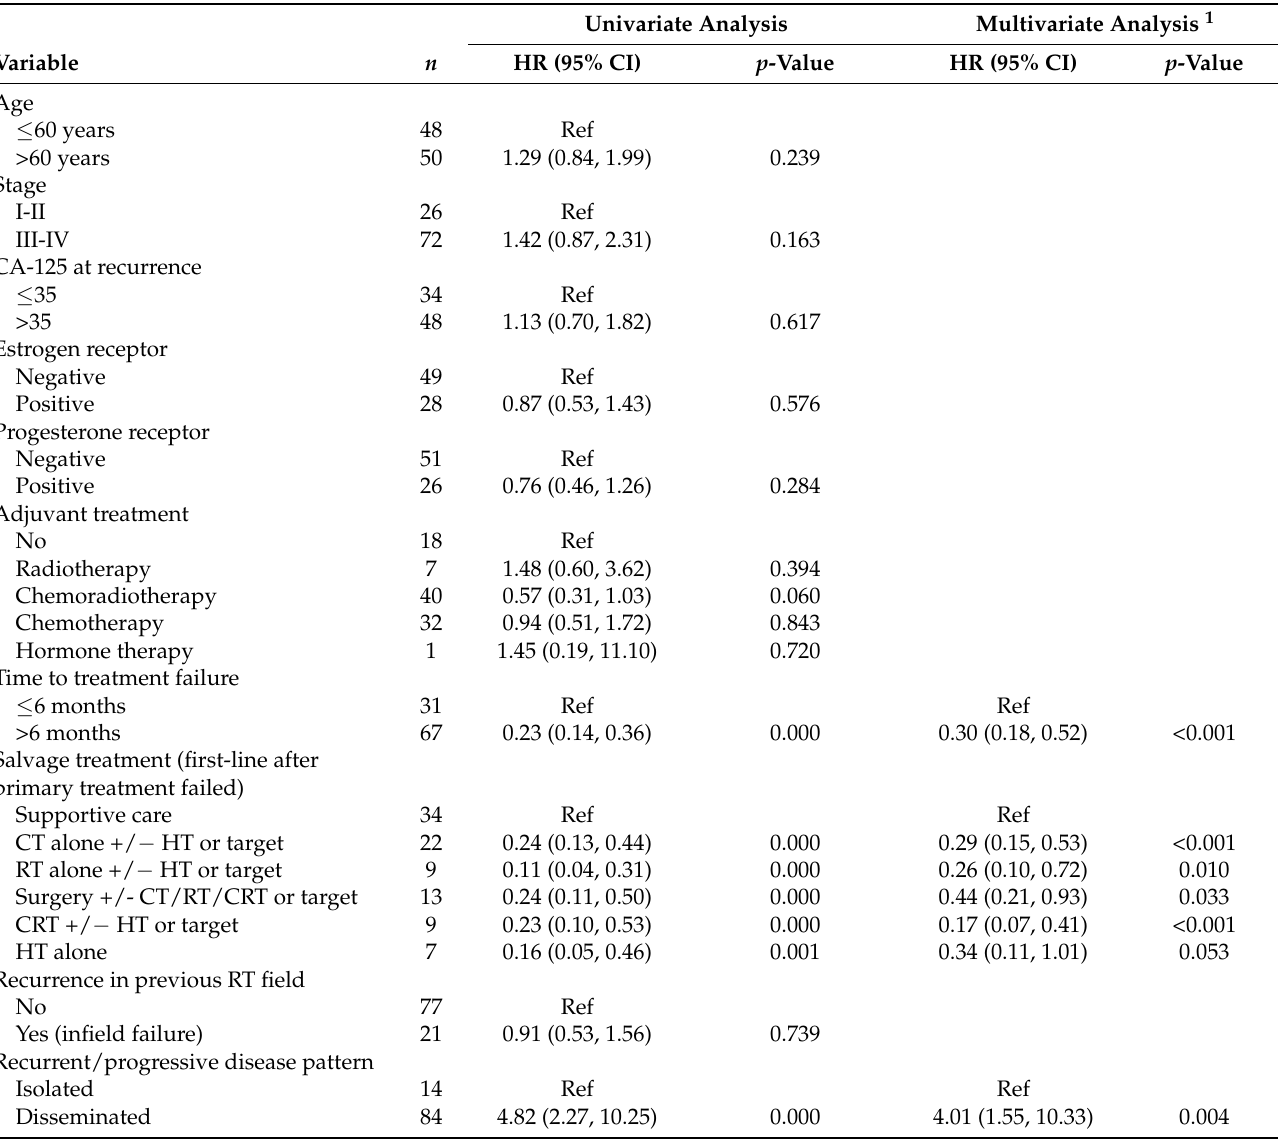
Table 3. Univariable and multivariate analyses of cancer-specific survival in recurrent/progressive uterine carcinosarcoma patients ( N =